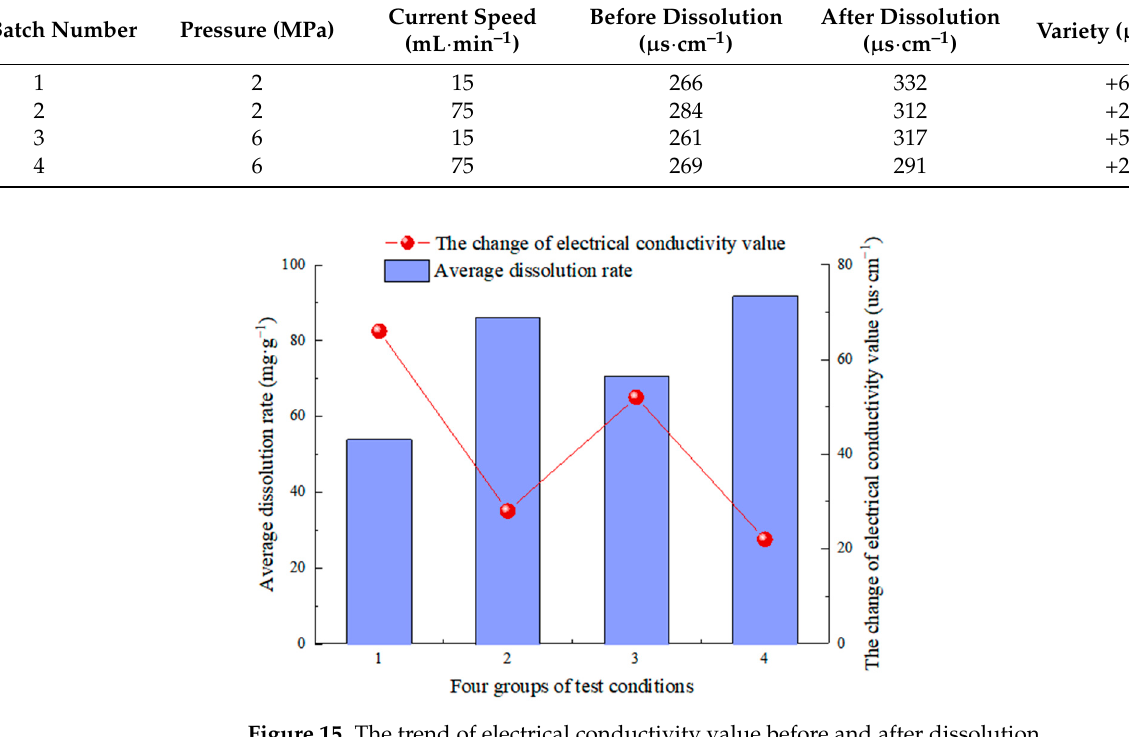
Table 6. Solution Ca 2+ concentration data under four groups of test